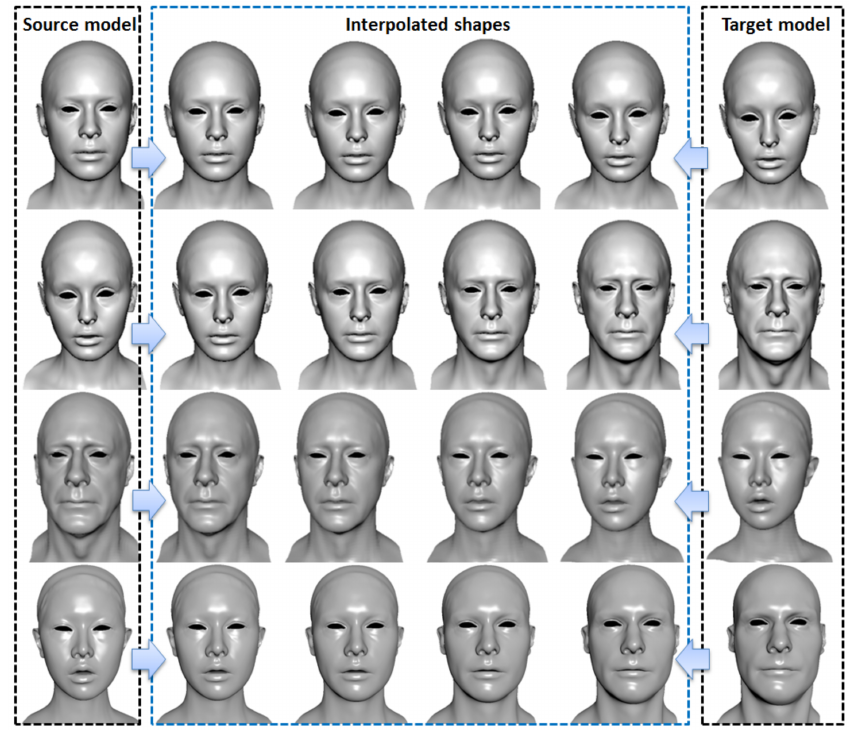
Figure 7. Facial models created by using Equation (25) to interpolate source facial models and target facial models, where the left column shows four source facial models, the right column depicts four target facial models, and the four middle facial models on each of the four rows are new created facial models by setting t = 0.2, 0.4, 0.6, and 0.8 in Equation